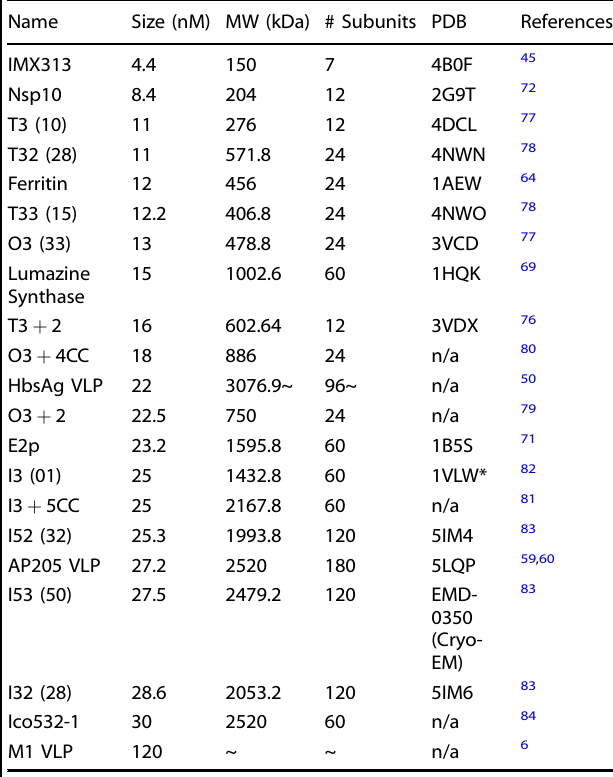
Asterisk (*) indicates that the engineered nanoparticle structure was not available and a PDB structure of the original building block was provided instead. Tilde (~) indicates that value may vary due to lipid